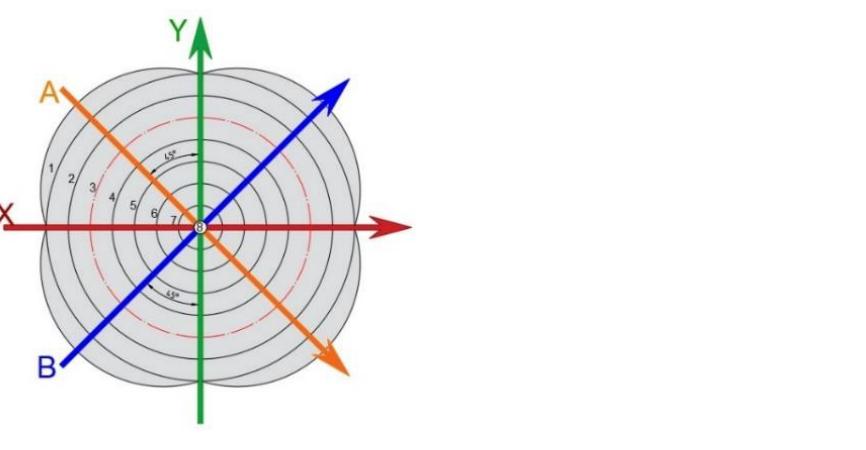
Figure 7. Lines and points to measure fiber intersection angles after drawing.